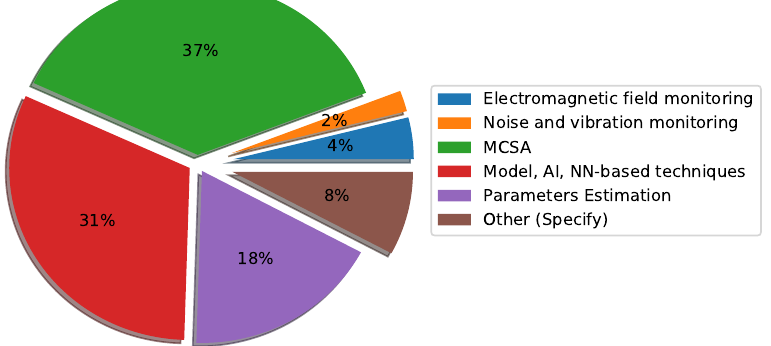
Figure 3. Distribution of the papers according to the technique used.